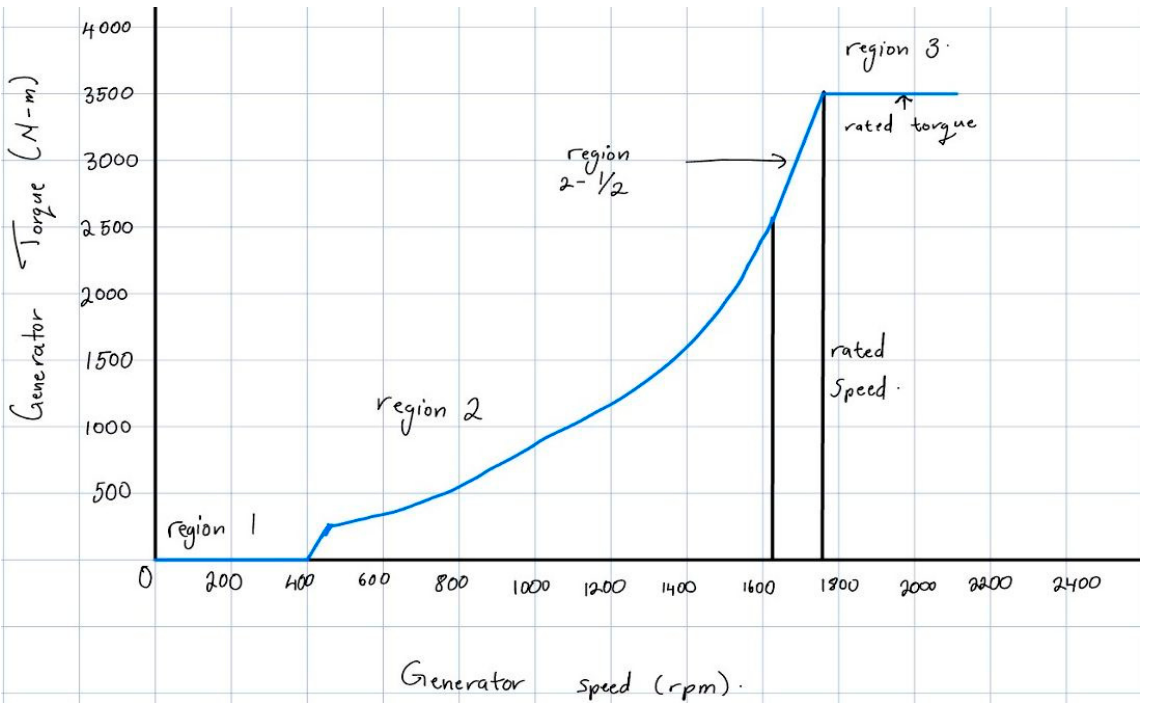
Figure 15. Regions of operation are shown in terms of generator torque vs. speed [28].